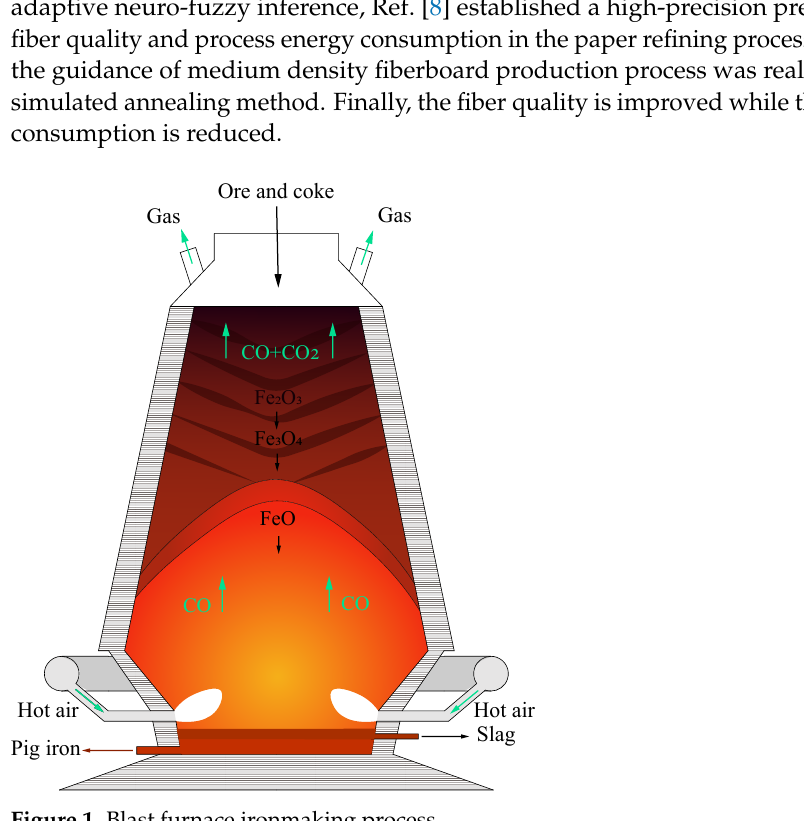
Figure 1. Blast furnace ironmaking